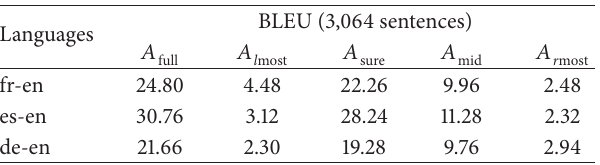
Table 12: Translation performance on different word alignment